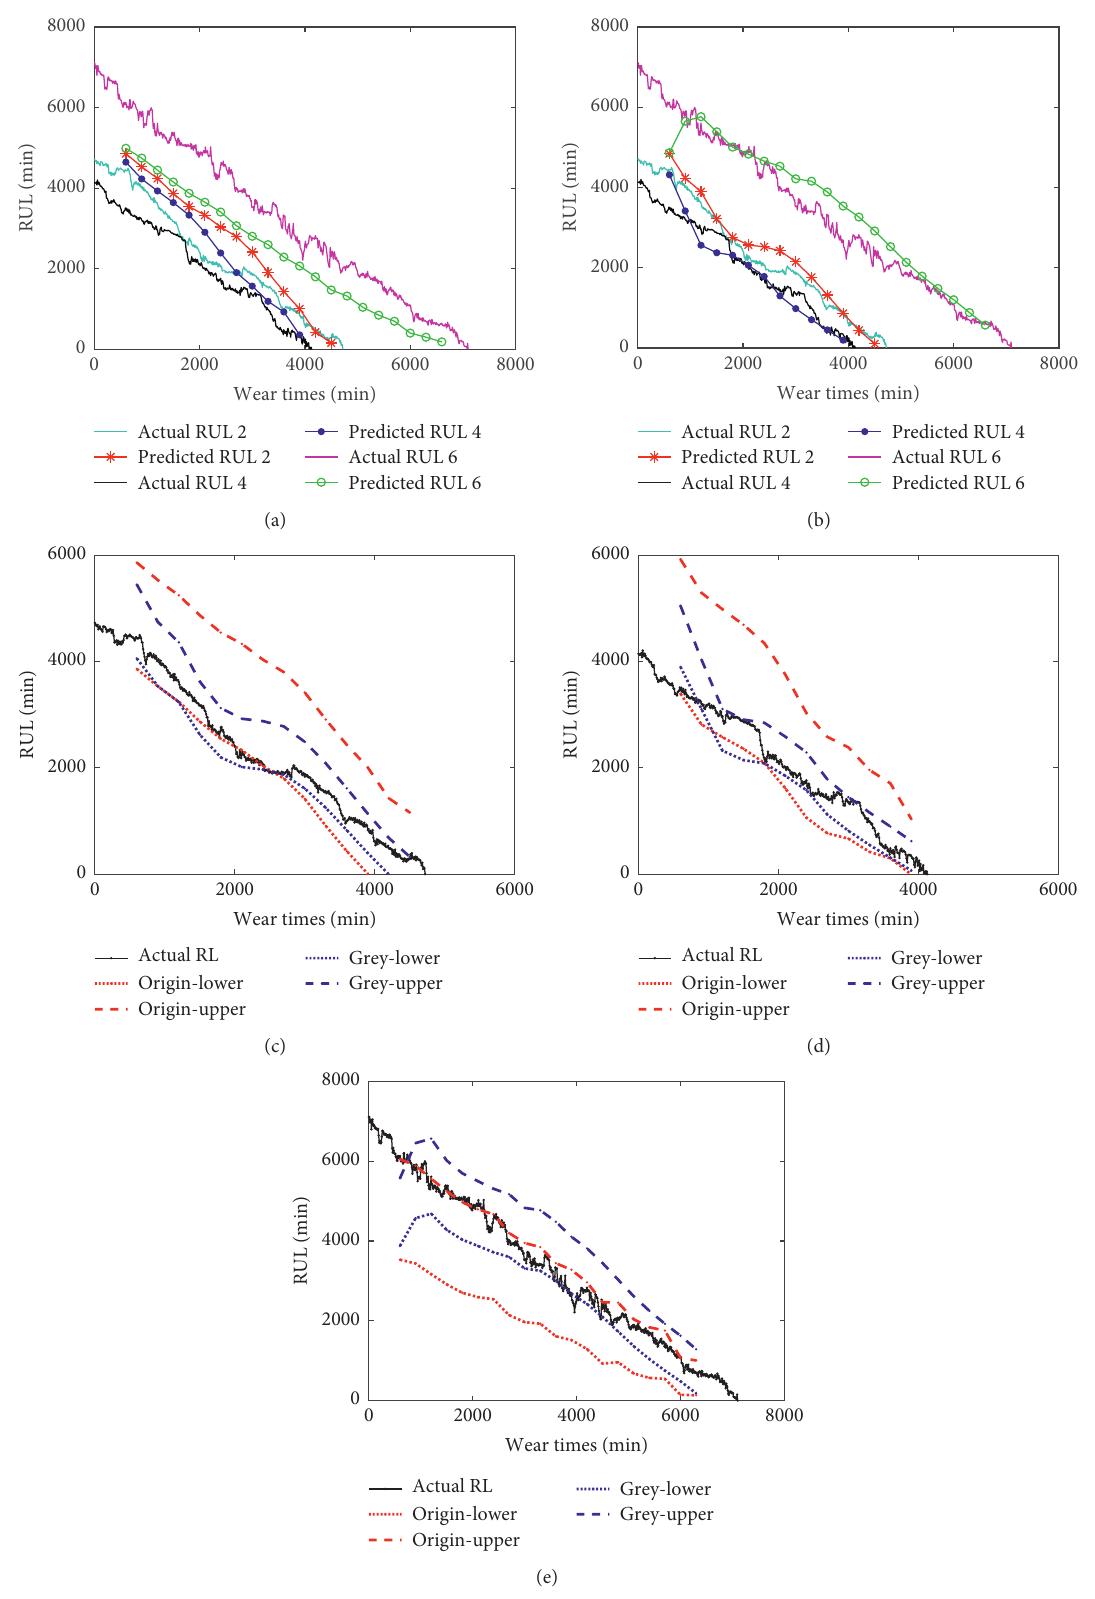
Figure 7: RUL and confidence interval for HSLL based on original wear depth and grey processing data. (a) Origin wear depth. (b) Grey processing data. (c) Confidence interval of samples 2. (d) Confidence interval of samples 4. (e) Confidence interval of samples